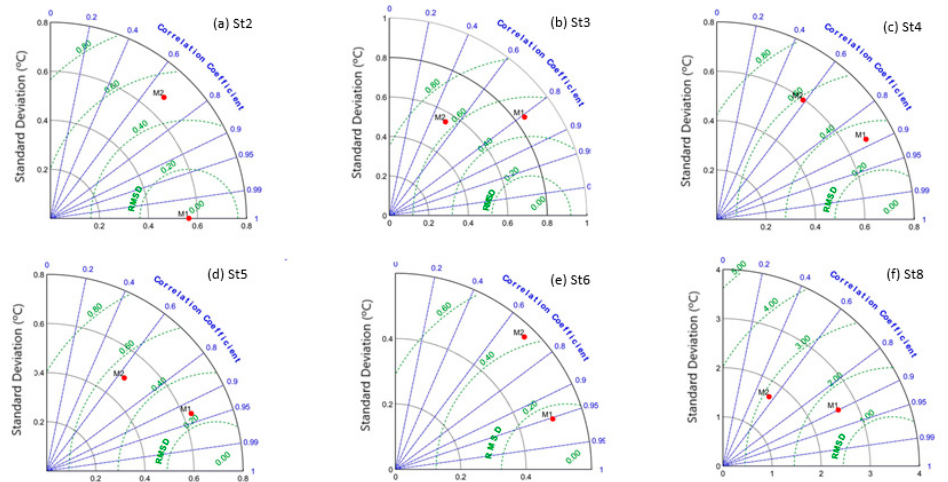
Figure 19. Taylor diagrams for SC1 (M1) and SC2 (M2), for temperature and the lagoon stations: ( a ) St1, ( b ) St3, ( c ) St4, ( d ) St5, ( e ) St6 and ( f ) St8.